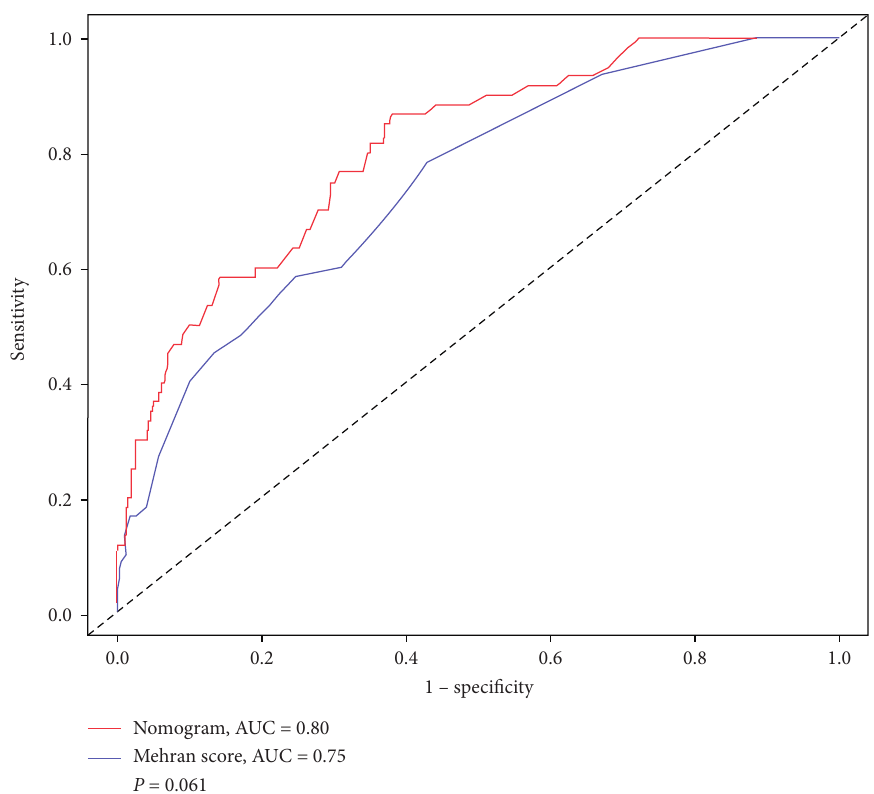
Figure 3: The receiver operator characteristic curves of the nomogram and Mehran score in the validation